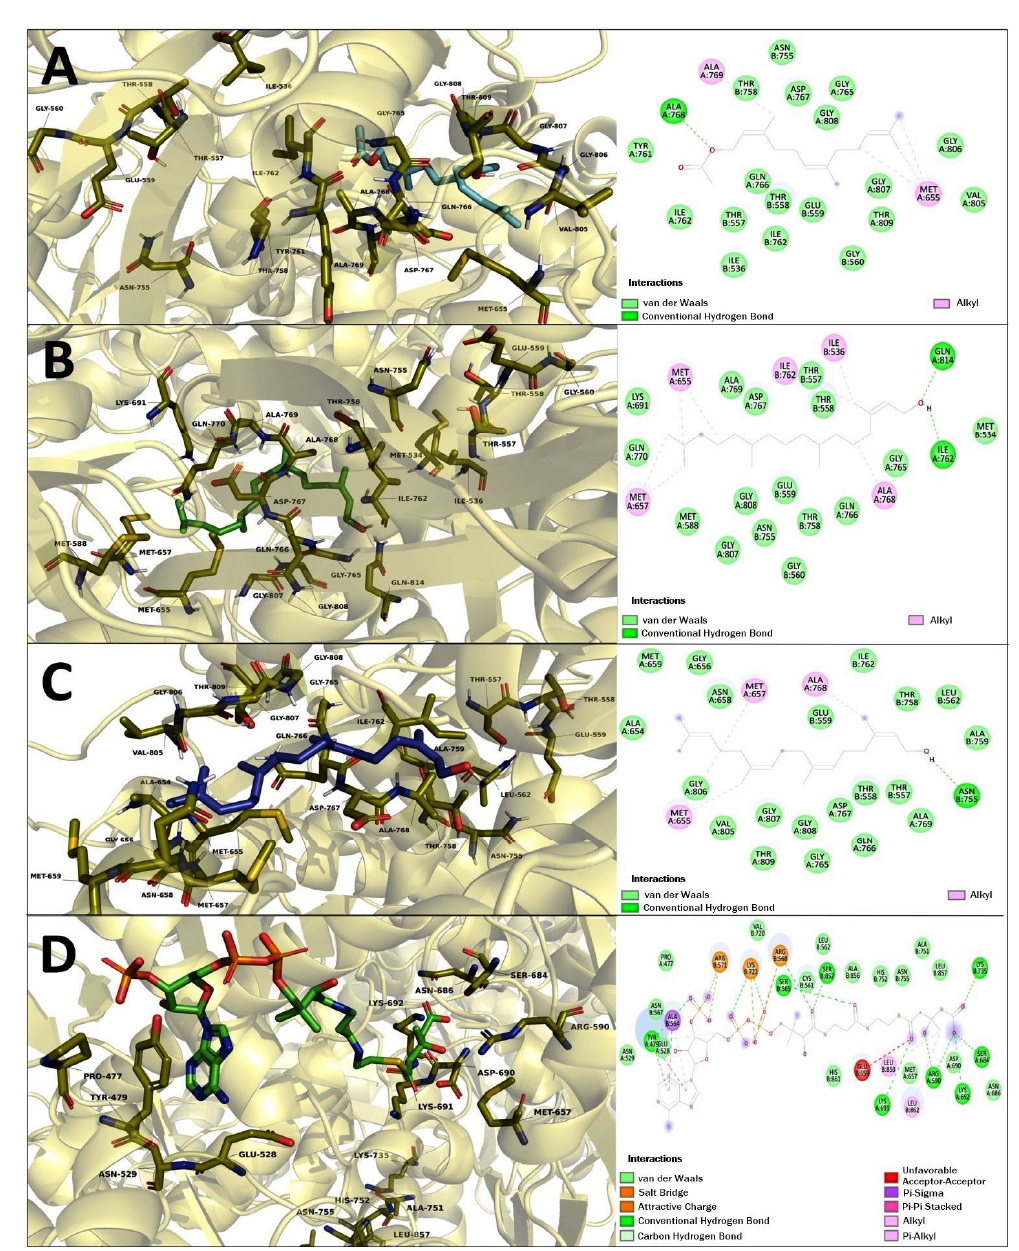
Figure 7. Molecular Docking of the terpenoids bound to HMG-CoA reductase, ( A ) farnesyl acetate, ( B ) phytol, ( C ) geranylgeraniol and ( D ) HMG-CoA substrate.